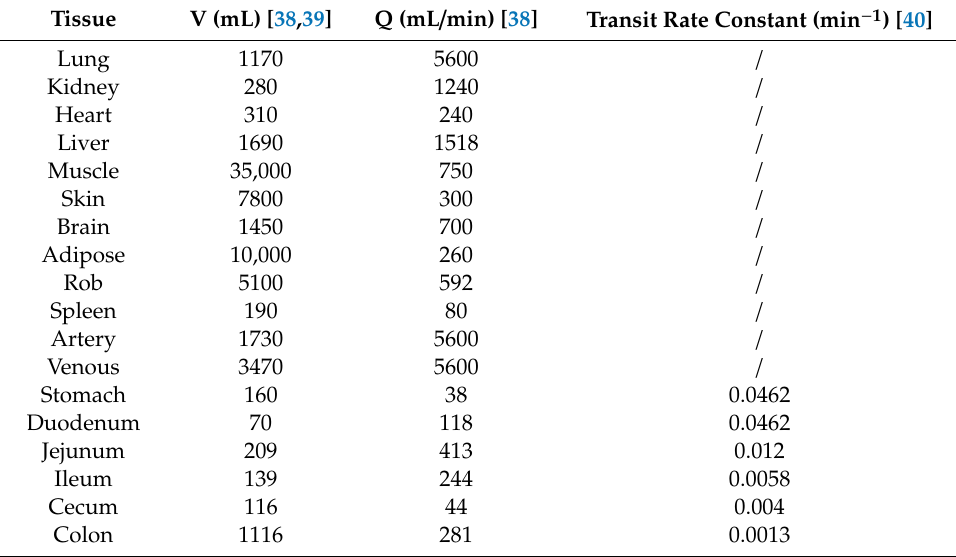
Table 1. Physiological parameters for humans used in the physiologically based pharmacokinetic PBPK